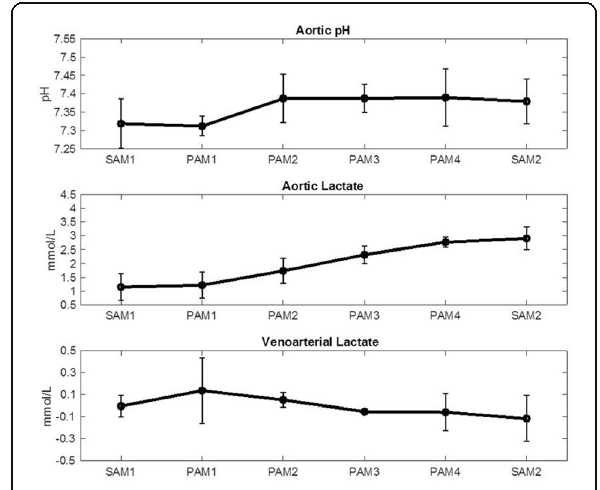
Fig. 4 Metabolic parameters measured. A Aortic pH, B Aortic lactate, C Venoarterial lactate. Error bars show the standard deviation. SAM, pump- supported working mode; PAM, passive afterload working